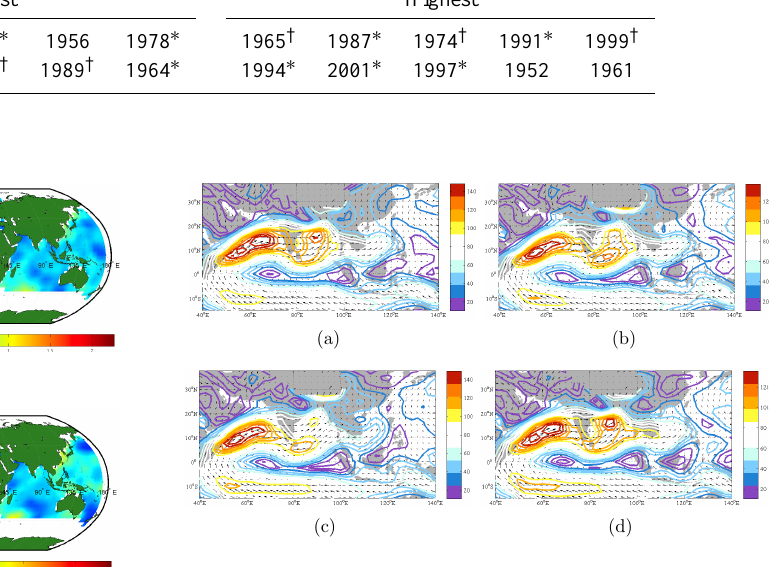
Fig. 8. Average moisture transport at 700mb–1000mb in the mon- soon months (JJAS) during five years with lowest or highest PCs values from Joint PCs. (a) Years with lowest PCs values from Joint PC1; (b) years with highest PCs values from Joint PC1; (c) years with lowest PCs values from Joint PC2; (d) years with highest PCs values from Joint